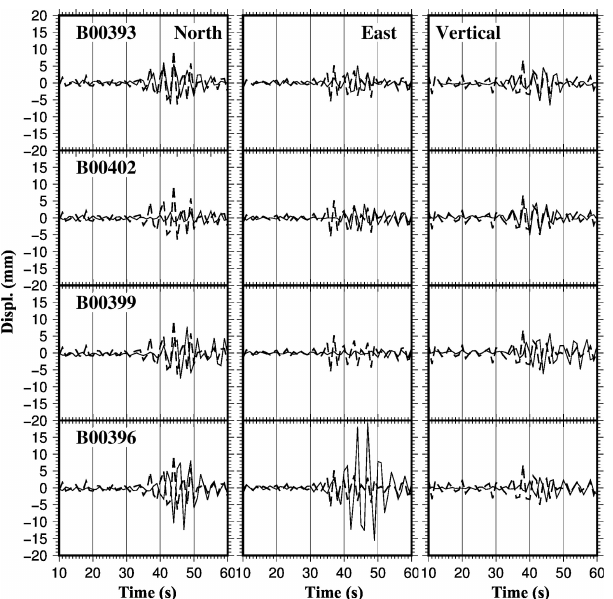
Figure 8. MEMS (thin solid line) and HRGPS (thick dashed line) displacements time series obtained after the filtering and the double- integration. Observations are presented for the three local geodetic components: North, East and Vertical, with the same sampling rate of 1Hz. The MEMS instrument code is reported in each figure. The horizontal axis is given in seconds after the main shock origin time: 01:36:32UTC of 24 August 2016. According to the epicentral dis- tances, the MEMS signals of the four stations are arranged in de- creasing order from top to bottom. (Built with the Generic Mapping Tool software GMT – Creative Commons Attribution 4.0 License.)